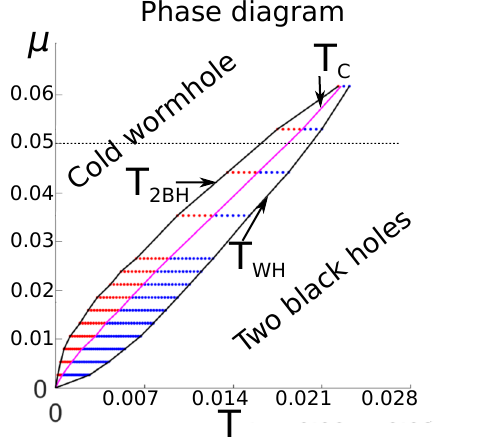
Figure 3 . A reprint of the phase diagram obtained numerically in [9] for J = 0 . 5 . The right solid black curve indicates T , purple line T and left solid black line T . The dashed horizontal WH c 2BH line is at µ = 0 . 05 , the value of µ we will use in our real time numerical simulation. In this case β 2BH ∼ 61 , β c ∼ 54 , β WH ∼ 49 .